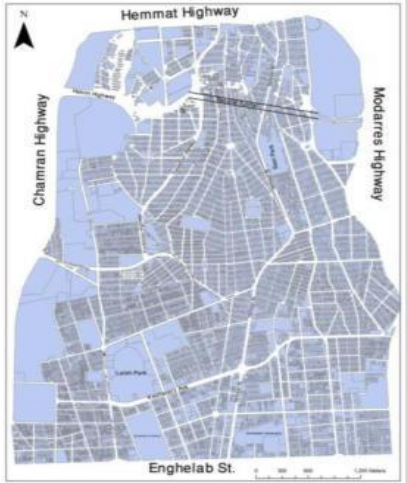
Figure 4. Position streets and important elements such as urban freeways, parks and universities in zone #6 of Tehran